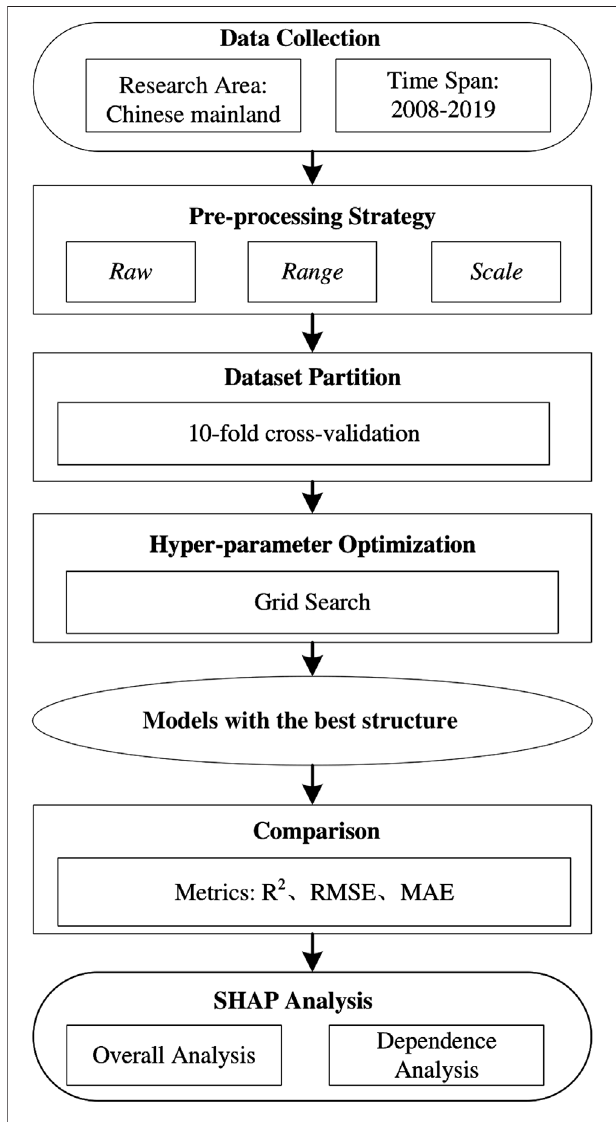
FIGURE 2 | Procedures of